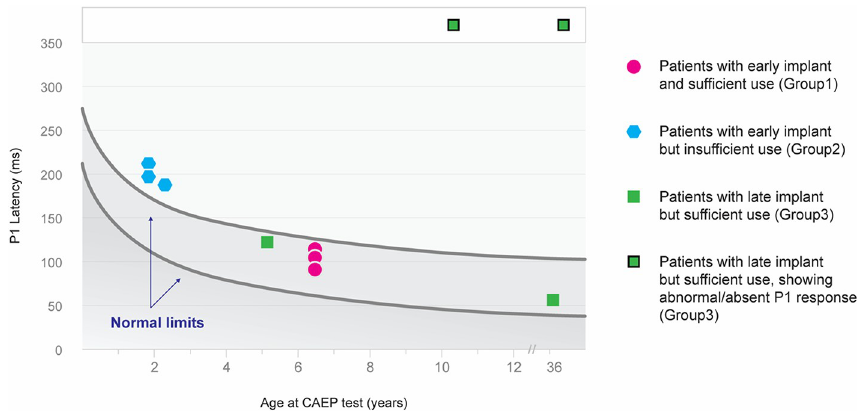
Fig 2. P1 latency as a function of age for 10 patients fit with CI. Circles indicate latencies in the patients within the normal P1 range after sufficient use with early (pink circles) or late (green squares with no border line) implantation. Hexagons indicate latencies in patients with delayed P1 response who had insufficient use of CI in spite of early stimulation. Green squares with black borderline indicate latencies in the patients with late implantation and insufficient use resulting in abnormal/absent P1 response. The upper and lower solid lines indicate the 95% confidence intervals for the 190 normal-hearing data (Sharma et al. 2002a).